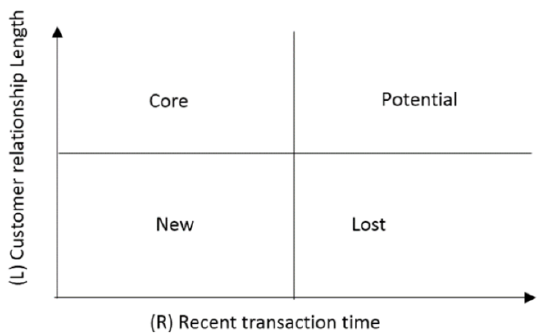
Figure 2. Customer clustering on a customer loyalty matrix basis